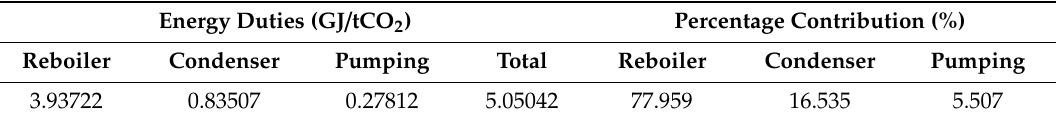
Table 6. Energy requirements within the capture unit during the confirmation experiment.